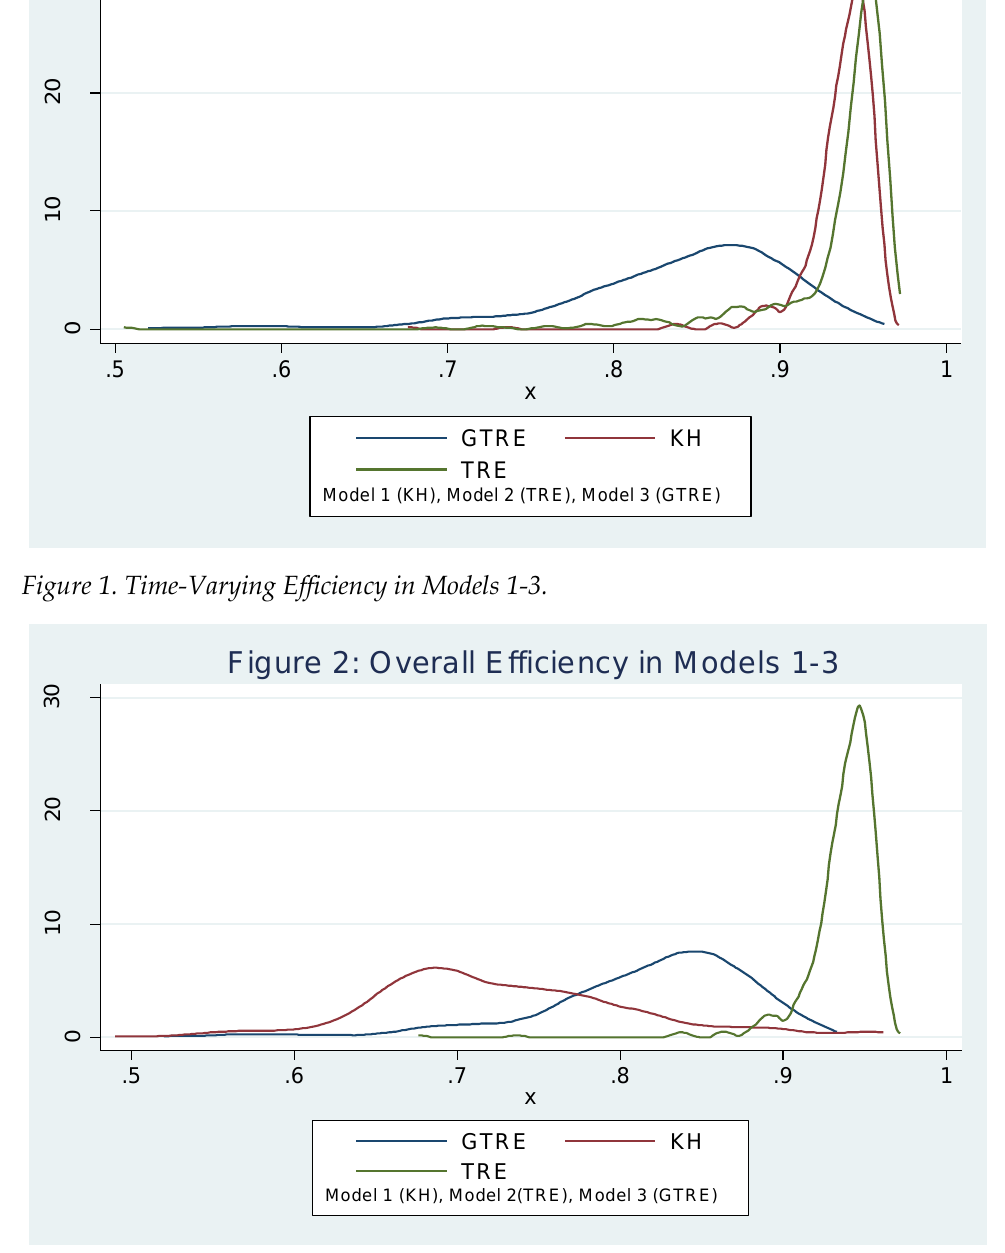
Figure 1: Time-varying efficiency in Models 1-3